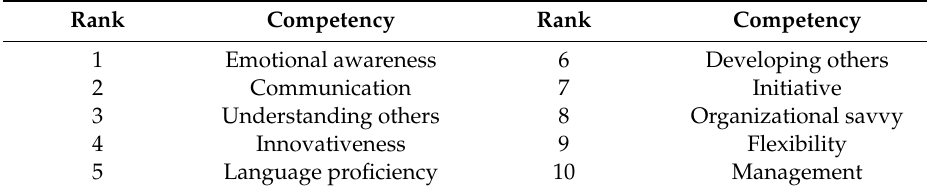
Table 8. The ranking of 10 creative tension competencies.